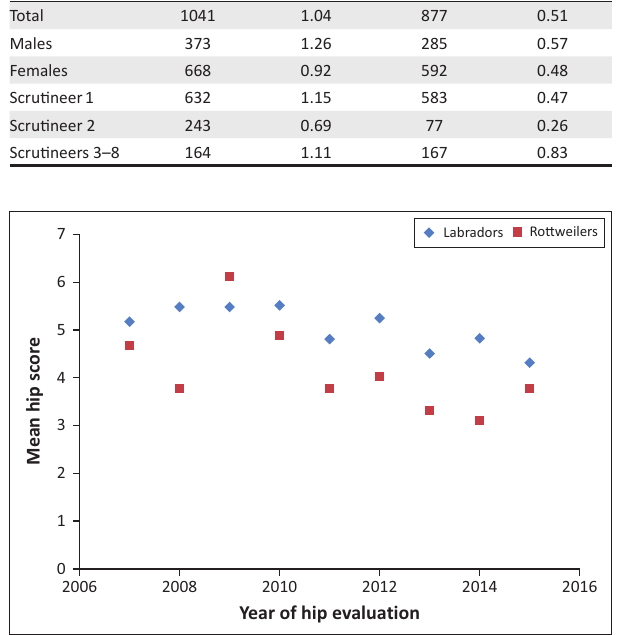
FIGURE 2: Mean total numerical score (0–18) of hip dysplasia in Rottweilers and Labrador retrievers per year from 2007 to